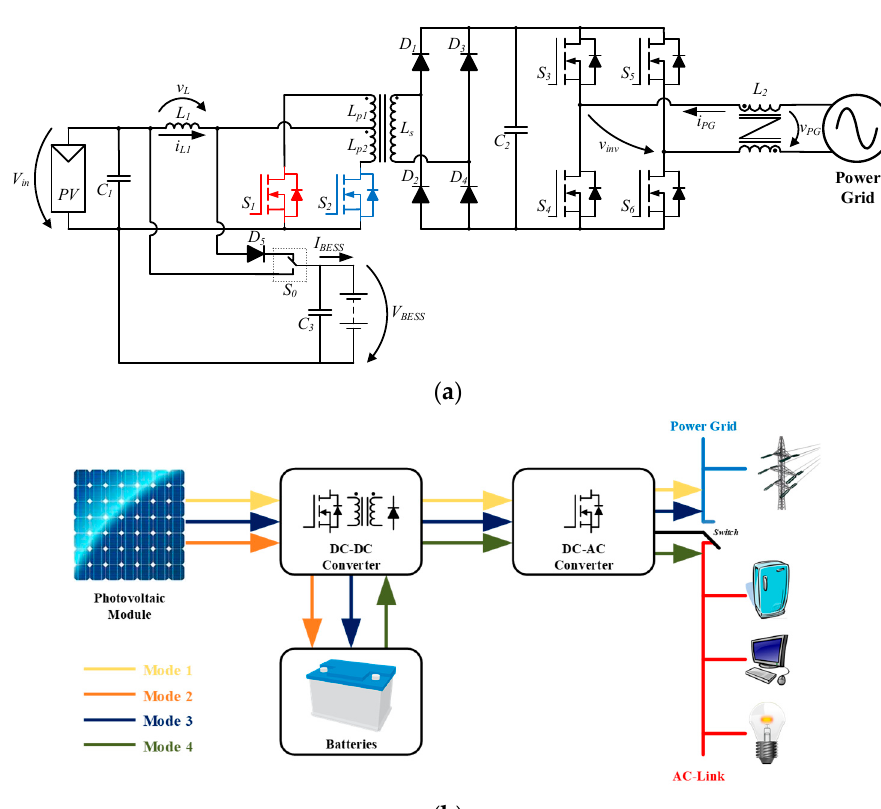
Figure 1. Topology and operation modes of the proposed multifunctional isolated microinverter: ( a ) Schematic of the microinverter topology; ( b ) Representation of the operation modes.